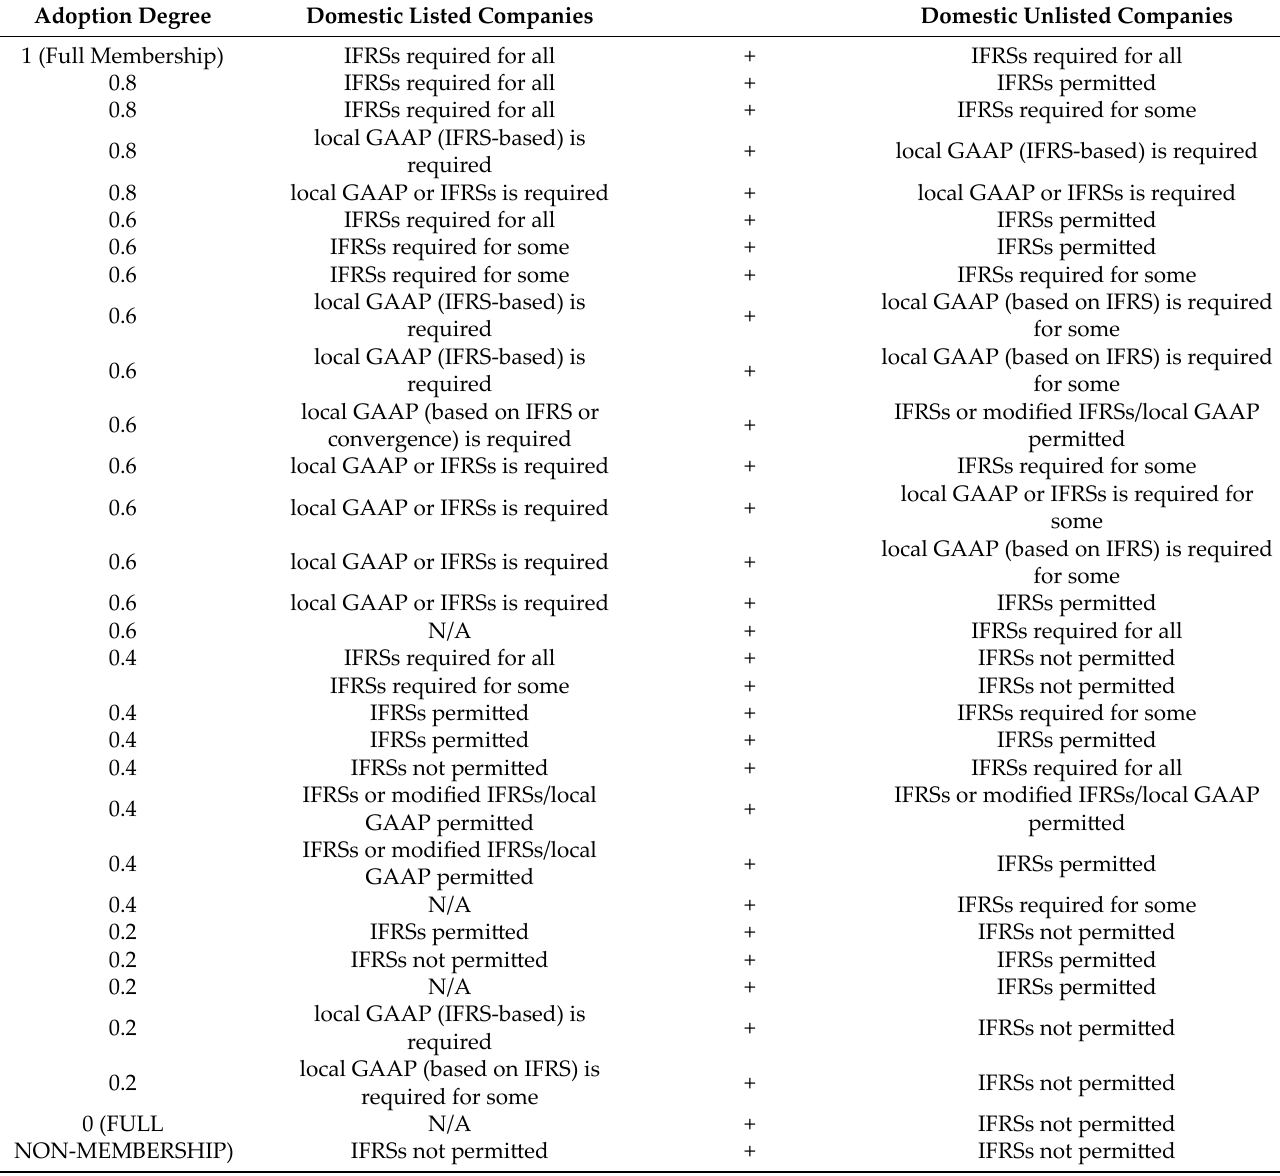
Table 2 summarizes the output for the IFRS adoption degree variable. Table 2. IFRS adoption